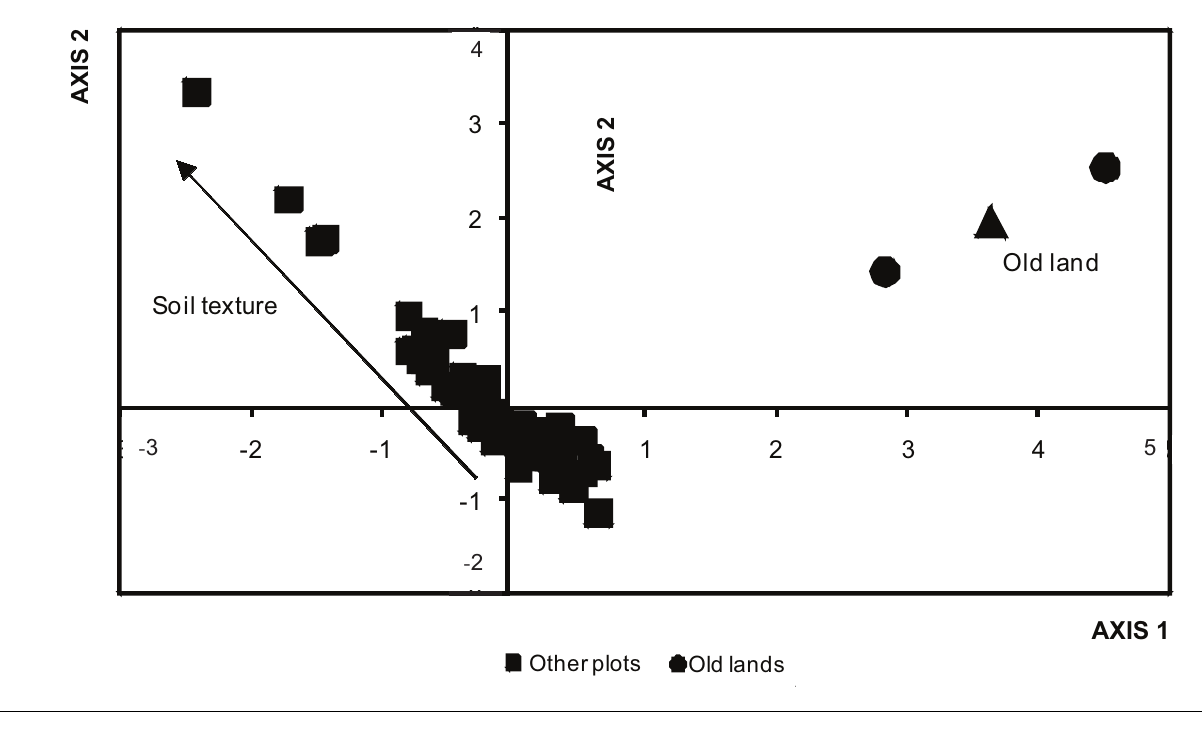
(as controlled by the position of the sample in the landscape and by its soil texture) as the major determinant of